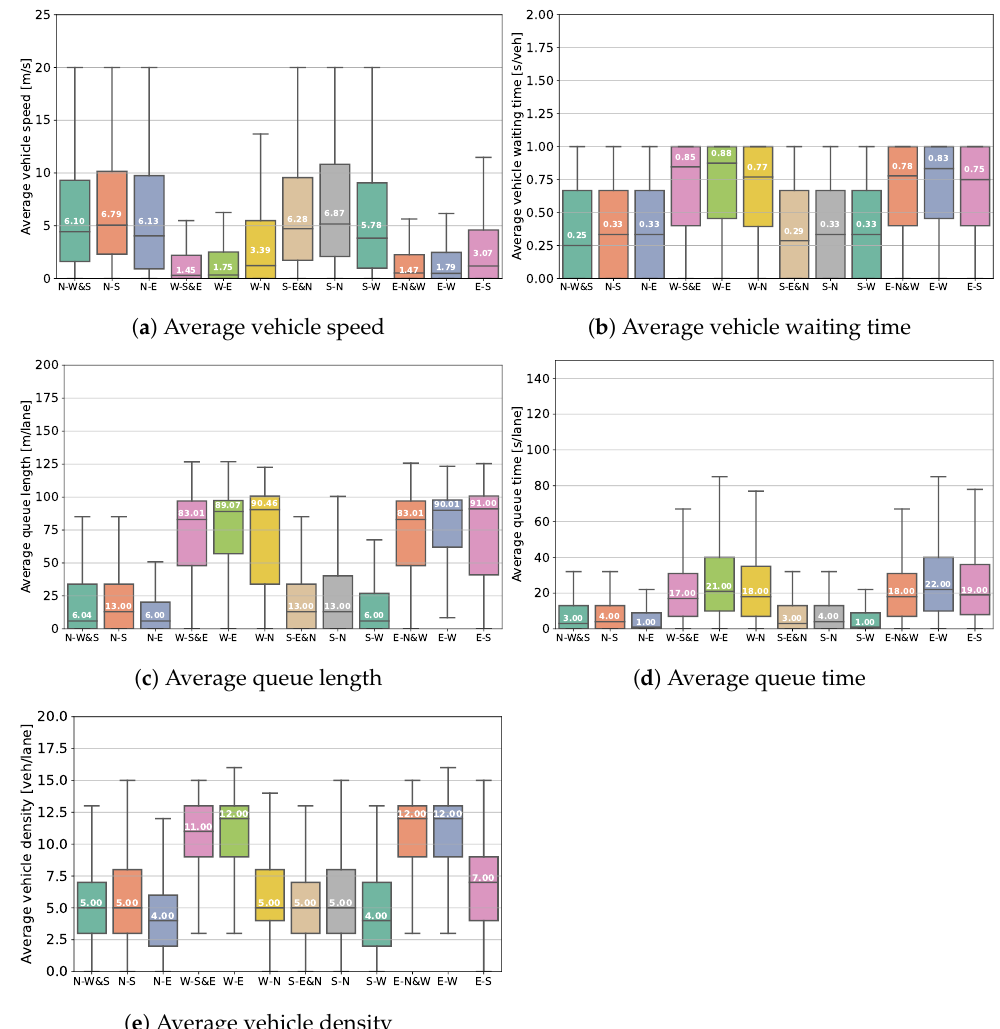
Figure 12. Performance estimation of the proposed method in each